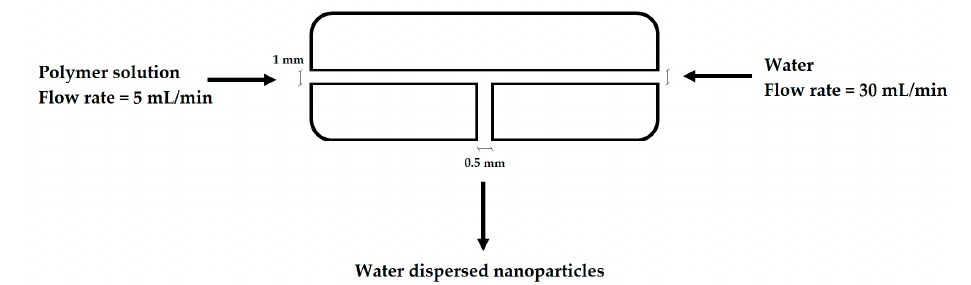
Figure 1. Mixing device schematization.